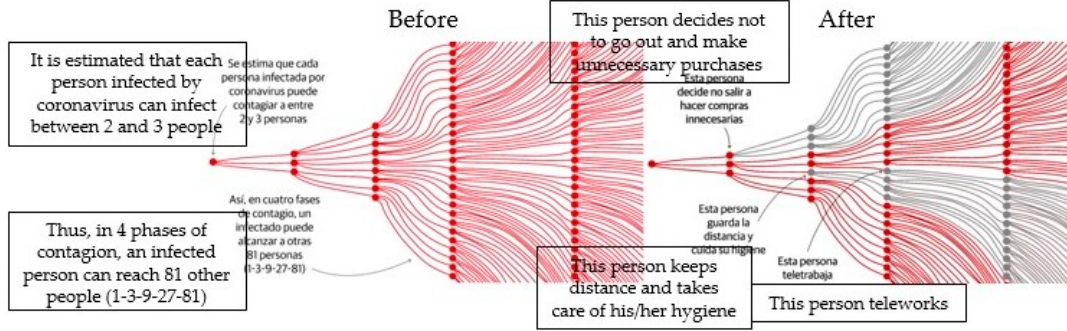
Figure 10. Propagation tree before and after social distancing [66].